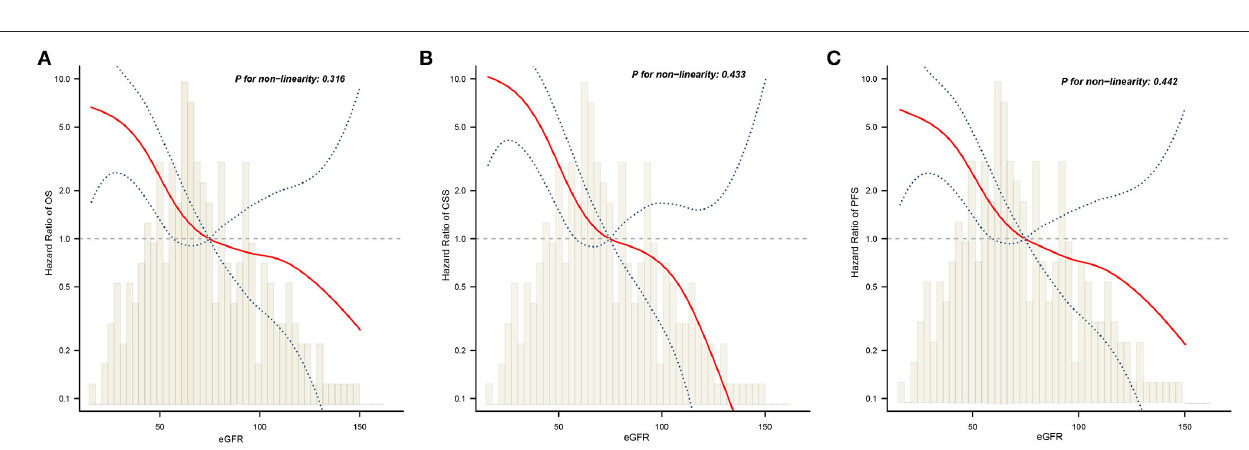
FIGURE 4 | The adjusted smooth fitting curve between postoperative eGFR and postoperative survival outcomes of UTUC patients. A linear relationship between postoperative eGFR and OS (A) , CSS (B) , PFS (C) was observed (all P > 0.05). The red solid line and blue dashed line represent the estimated values and their corresponding 95% confidence intervals. UTUC, upper tract urothelial carcinoma; eGFR, estimated glomerular filtration rate; OS, overall survival; CSS, cancer-specific survival; PFS, progression free